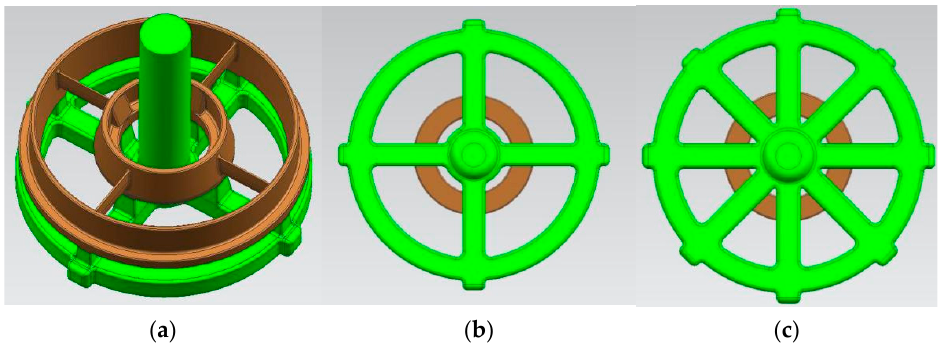
Figure 1. Simulation model of case. The out outer diameter of the outer ring is about 430 mm, and the inner diameter of the inner ring is about 200 mm. The average wall thickness is about 8–10 mm. The height of the case is about 70 mm.